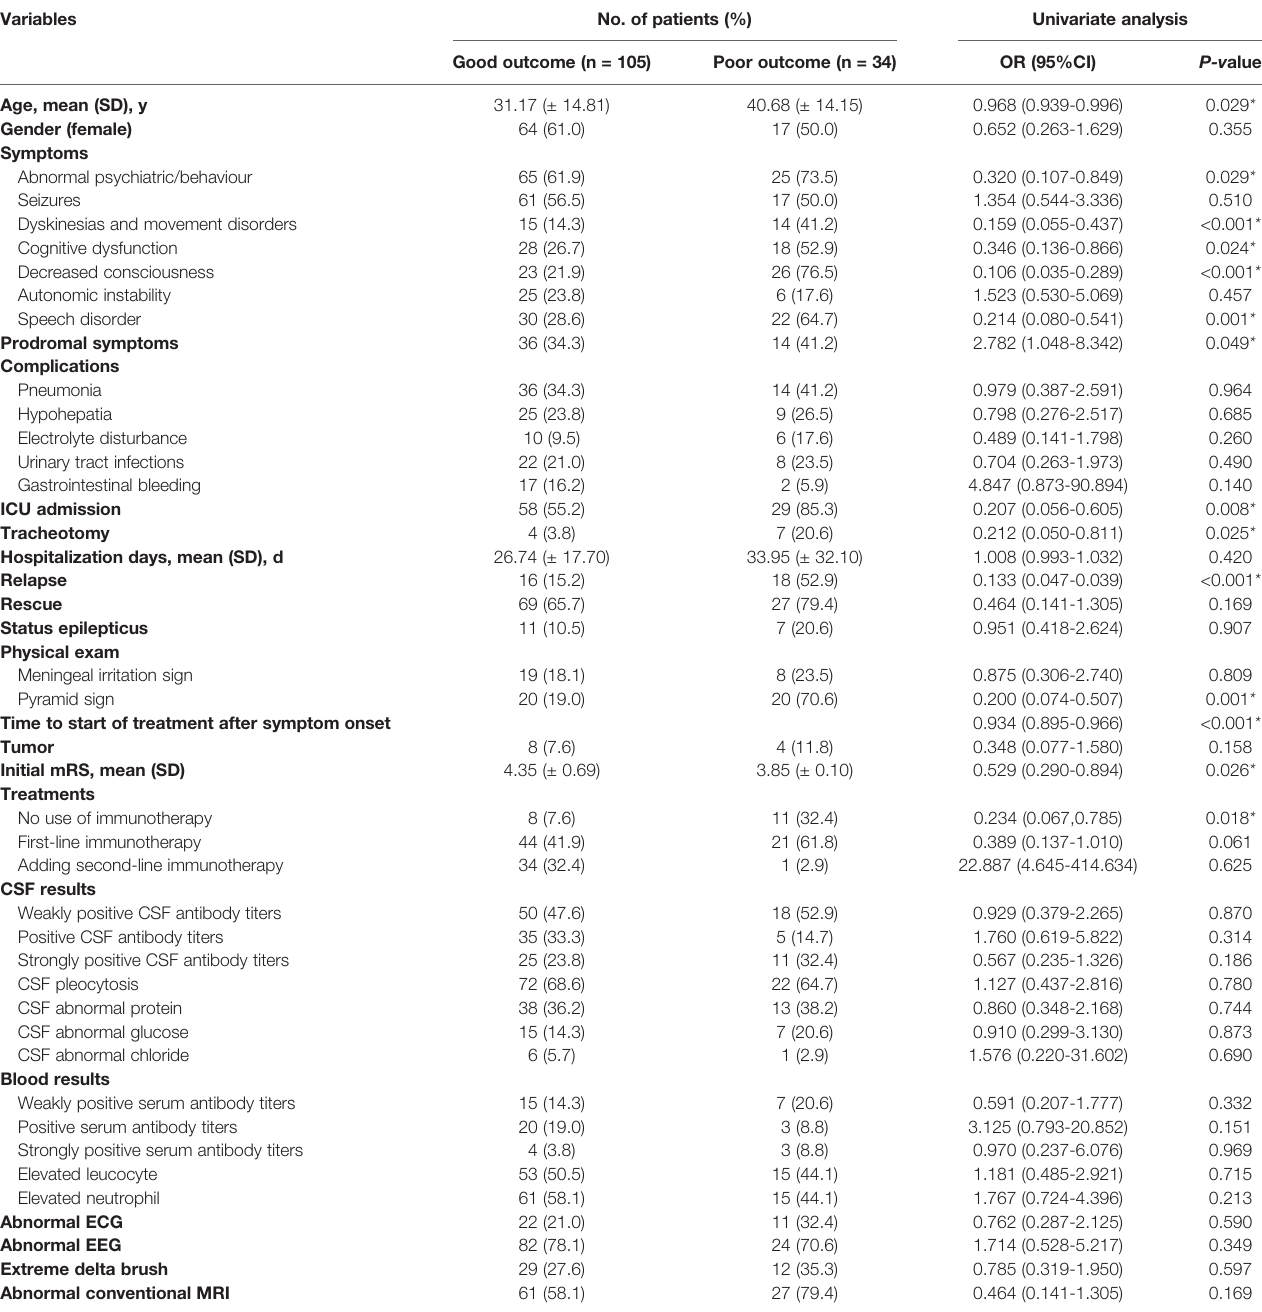
TABLE 1 | Clinical variables associated with poor functional outcomes at the 24-month follow-up in 139 patients with adult anti-NMDAR encephalitis. Variables No. of patients